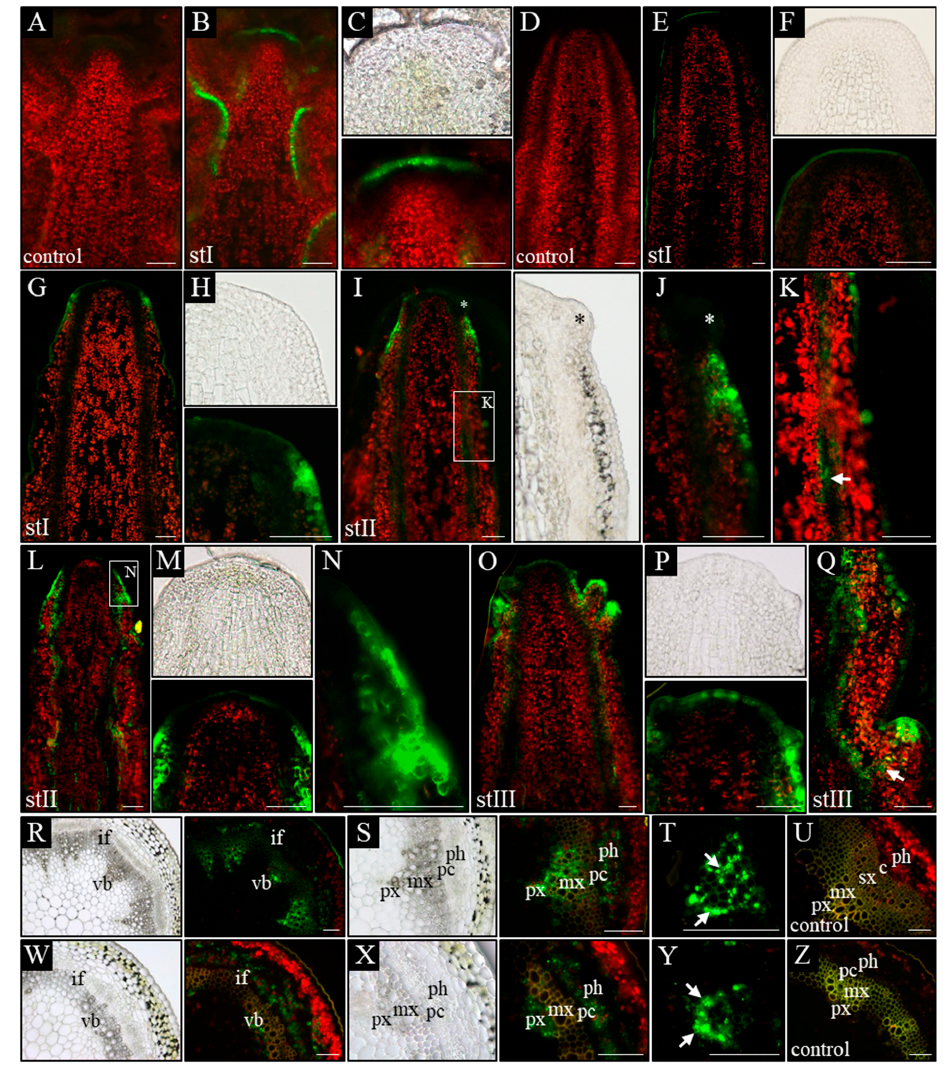
Figure 4. Spatial localization of the auxin response reporter p DR5:GFP activity. Longitudinal ( A – Q ) and transversal ( R – Z ) sections through the apical part of inflorescence stems of WT ( A – C , R – U ) and pin1 mutant ( D – Q , W – Z ) plants. On the longitudinal sections, in WT plants, the GFP signal is visible in the vascular strands ( B ) and the L1 layer of the meristem ( C ). In the pin1 mutant, in stage I, the activity of the p DR5:GFP transgene is not detected ( E , F ) or is present in the L1–L2 layers of the peripheral zone of the meristem ( G , H ); in stage II, GFP signal accumulates in the surface layers at the base of the organ primordia—primordium denoted with asterisk ( I , J ) and locally in the vascular bundles - denoted with arrow ( K ) or in the L1–L2 layers of the peripheral zone of the SAM and in all vascular bundles ( L – N ); in stage III, the GFP signal is visible in the L1 layer of the entire meristem, at the tip of the developing organs and in all vascular strands ( O , P ) as well as of the cells (denoted with arrow) connecting the tip of an organ primordia with the vasculature ( Q ). On the transversal sections, the activity of the p DR5:GFP transgene in WT plants is visible in the phloem, xylem and locally in procambial cells ( R – U ). In terms of the xylem, GFP signal accumulates in all xylem parenchyma cells—denoted with arrows ( S , T ). In the pin1 mutant GFP signal is visible in xylem and phloem ( W – Z ). In terms of the xylem, GFP signal is present only in the parenchyma cells on the protoxylem side—denoted with arrows ( Y ). ( A , D , U , Z ) Tissue autofluorescence (control); ( C , F , H , J , M , P ) magnifications of the meristems. St I–III—successive developmental stages; vb—vascular bundle, if—interfascicular fibers, px—protoxylem, mx—metaxylem, sx—secondary xylem, ph—phloem, pc-procambium, c—cambium. Scale bare 50 µ